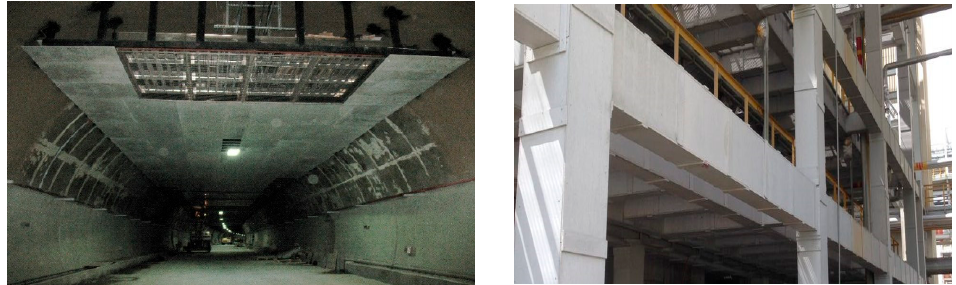
Figure 3. Fire protection of tunnel structural steel with Pyro-Safe Aestuver Т slabs cladding. ( Left ): Fire protection in Tunnel 1, relief road for Kurortny Avenue, city of Sochi, 2011–2012; ( Right ): structural steel protection at Taneco refinery plant, city of Nizhnekamsk, 2013–2017.